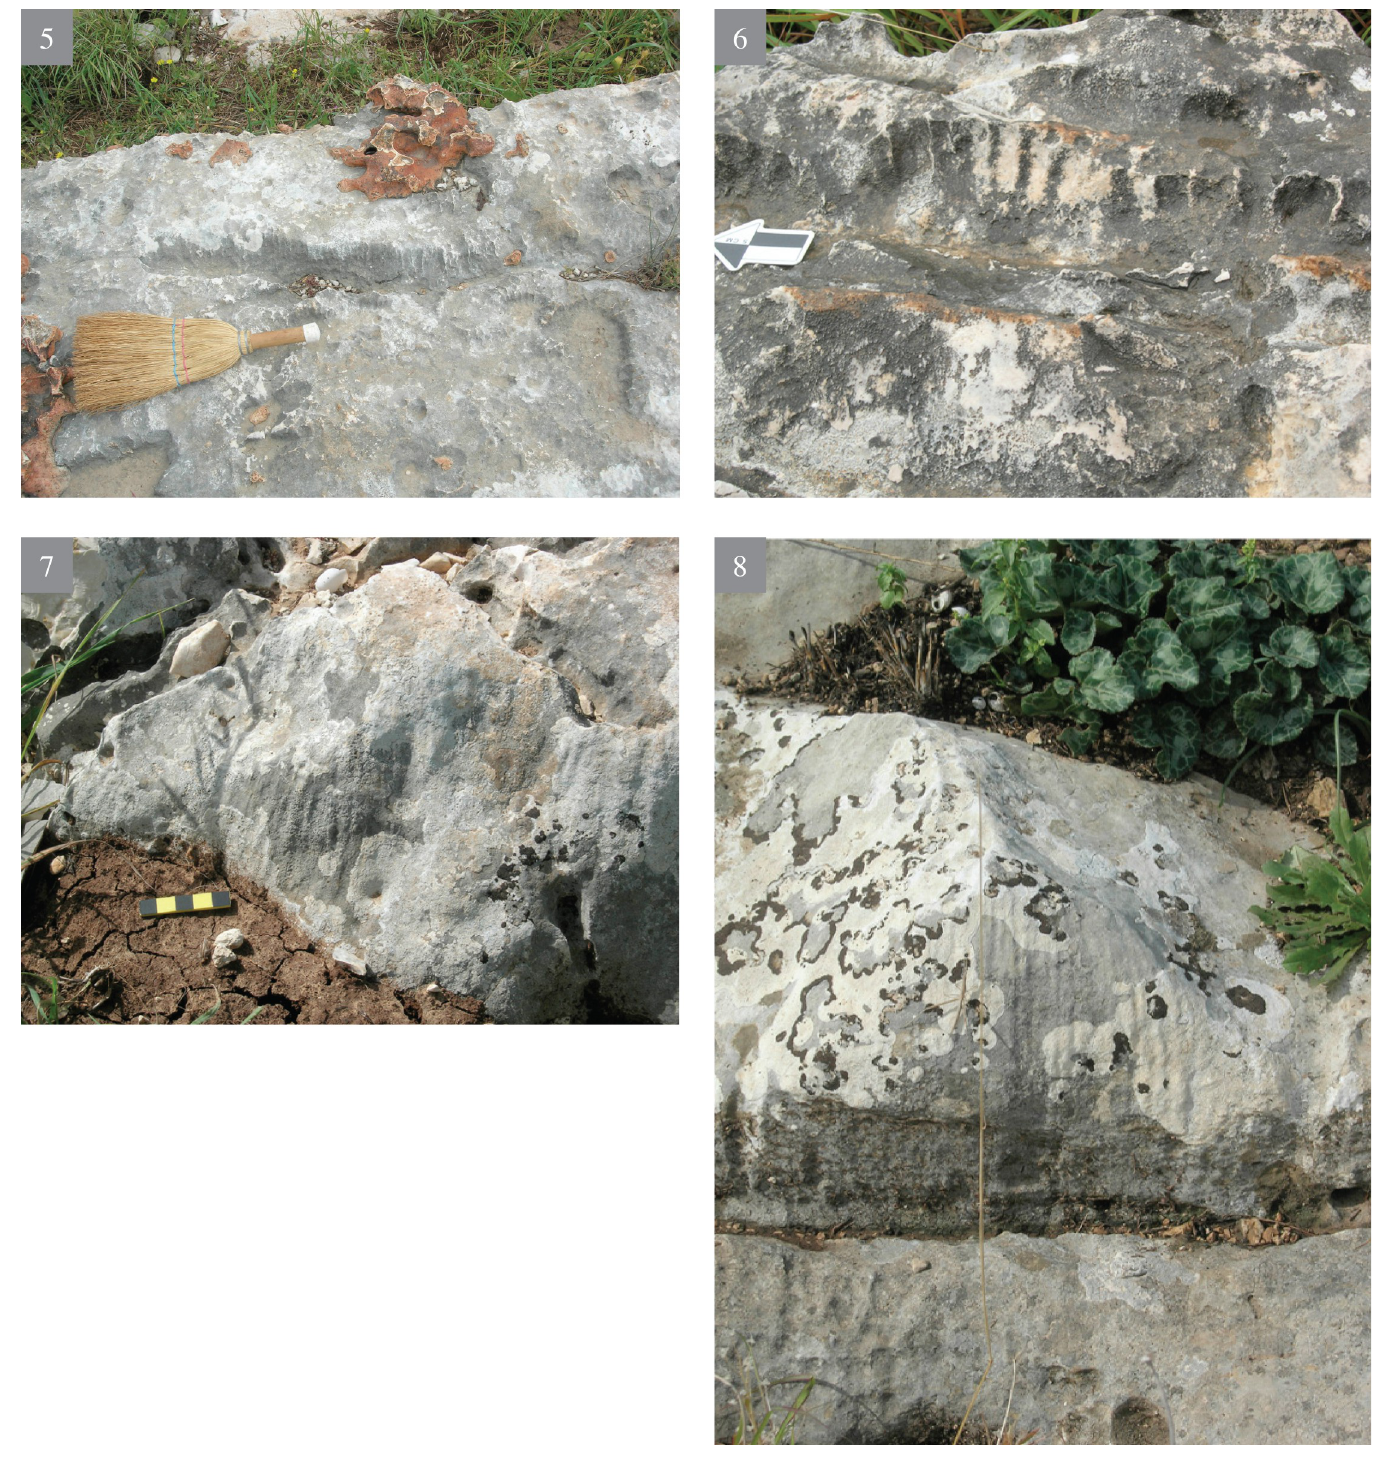
Fig 5. Rock damage resulting from flint quarrying of the Bi’na Formation bedrock (voids) and different types of quarrying marks (5–8).